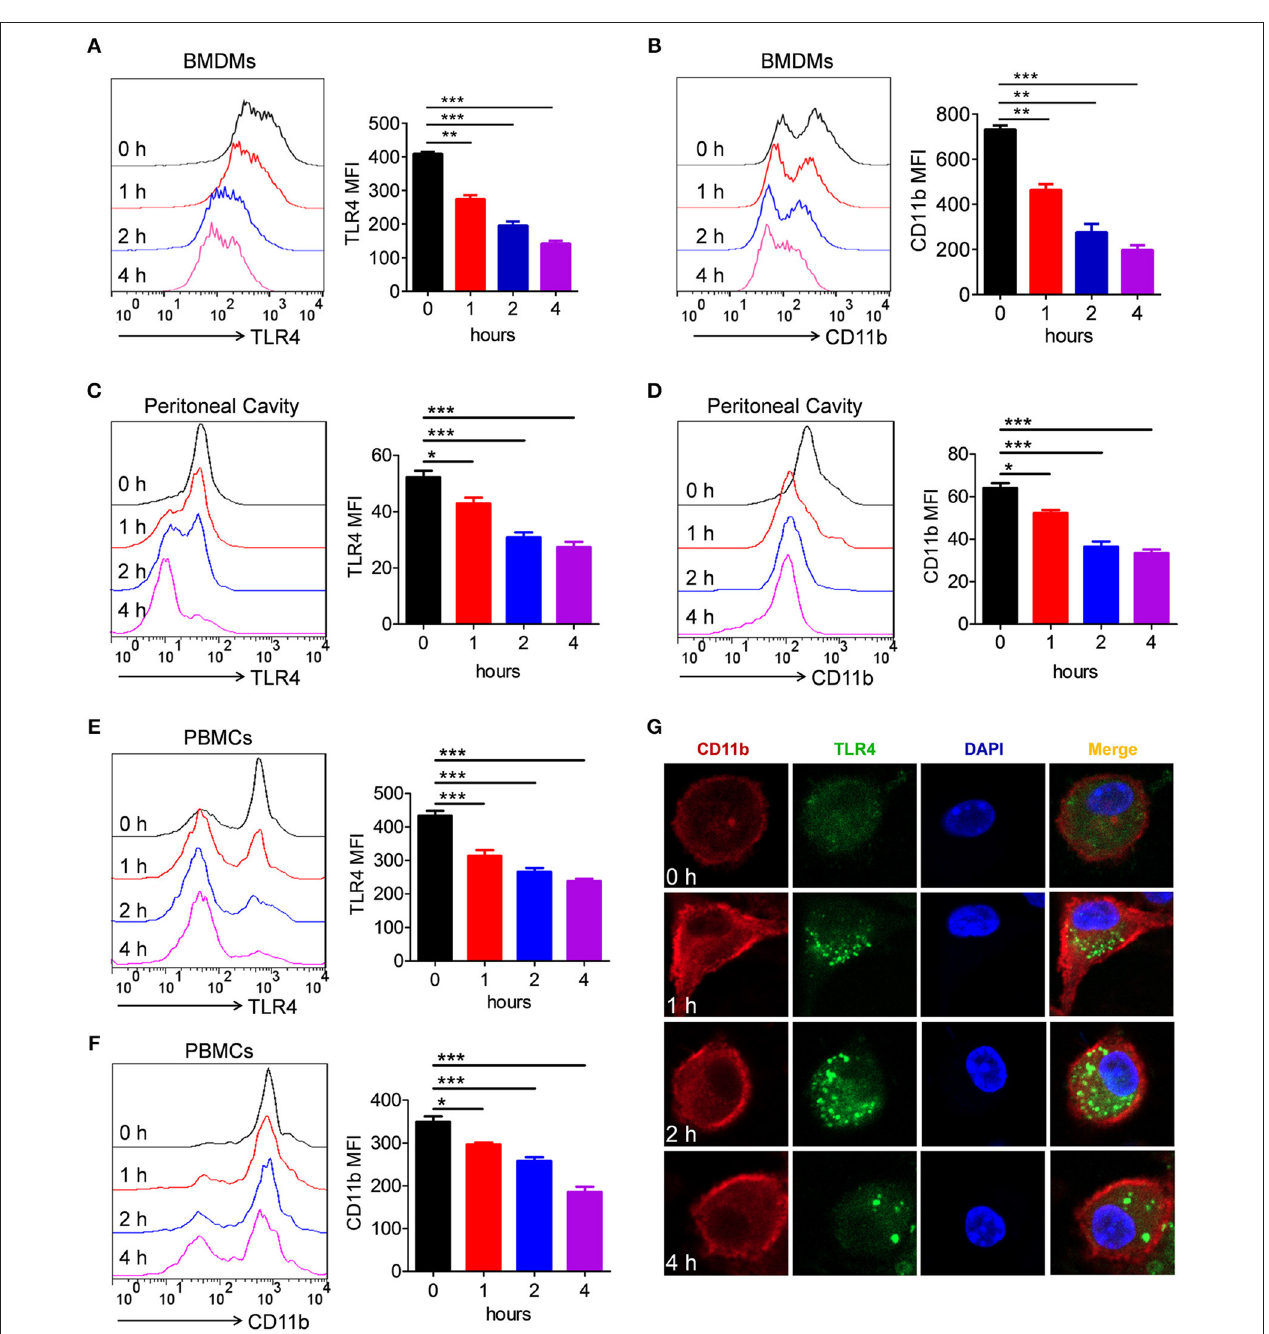
FIGURE 6 | Activation of TLR4 by LPS could endocytose CD11b in macrophages. (A, B) BMDMs were treated with LPS (200ng/ml) and IFN- γ (10ng/ml) for 1, 2, and 4h. FACS analysis was performed to assess the expressions of TLR4 (A) and CD11b (B) in BMDMs. (C–F) C57BL/6 mice were stimulated by LPS (10 µ g/g of body weight) for 1, 2, and 4h. FACS analysis was performed to assess the expressions of TLR4 (C) and CD11b (D) in peritoneal cavity, as well as to assess the expressions of TLR4 (E) and CD11b (F) in PBMCs. (G) BMDMs containing slides were treated with LPS (200ng/ml) and IFN- γ (10ng/ml) for 1, 2, and 4h, and then, the cells were fixed and permeabilized. After staining with anti-TLR4 mAb and anti-CD11b mAb, cells were incubated with an Alexa Fluor 488- and 647-conjugated secondary antibody and analyzed by fluorescent staining. Red represents CD11b; green represents TLR4; light blue represents nuclei with DAPI; and yellow represents merged TLR4 and CD11b. For in vitro studies, the data represent one out of the three biological replicates, each with three technical replicates. The data are shown as the means ± SEM ( n = 6 replicates) and are representative of three independent experiments. Error bars represent S.E.M. * p < 0.05, ** p < 0.01, *** p < 0.001, as determined by one-way analysis of variance (ANOVA) post-hoc Tukey Multiple Comparison Test.